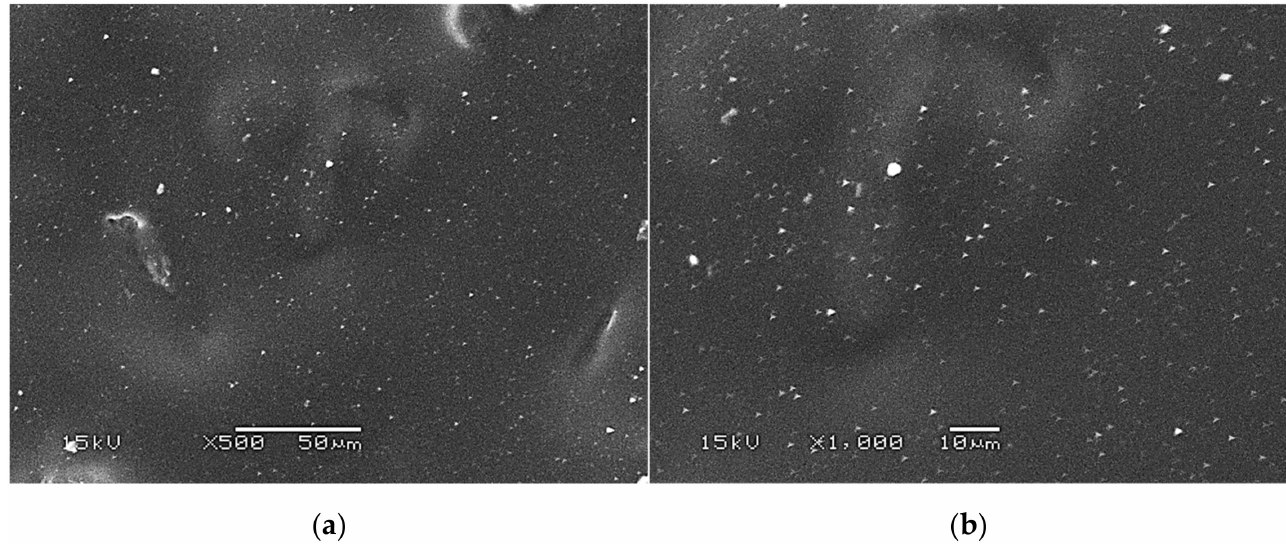
Figure 7. SEM images of unmodified hydrogels at magnification × 500 ( a ) and × 1000 ( b